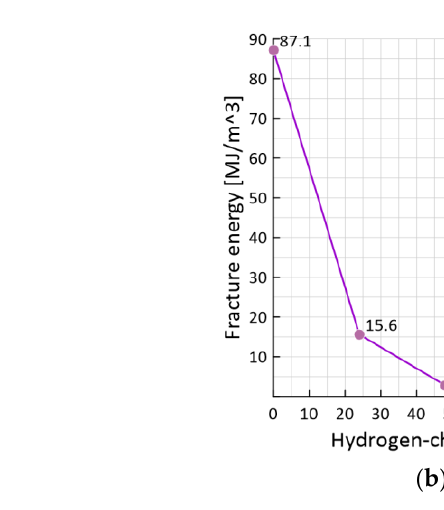
Figure 10. The effect of hydrogen-charge time on the fracture energy: with 0% ( a ) and 75% ( b ) pre- strain samples.